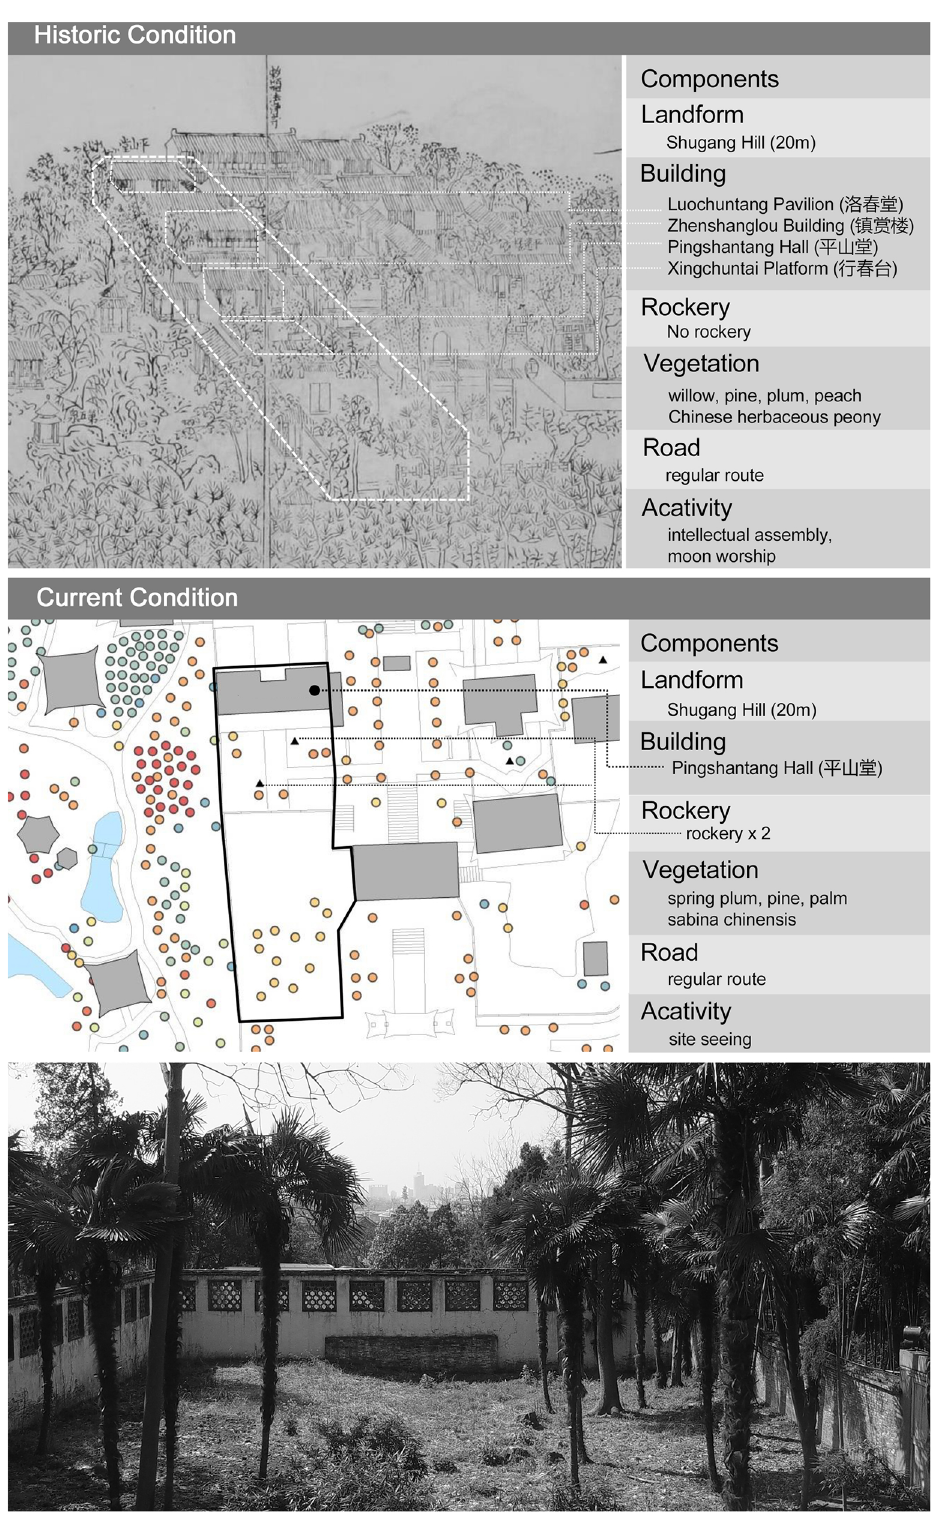
Fig. 7 Component restoration plan for Pingshantang Hall based on the digital cultural landscape database (Source: the